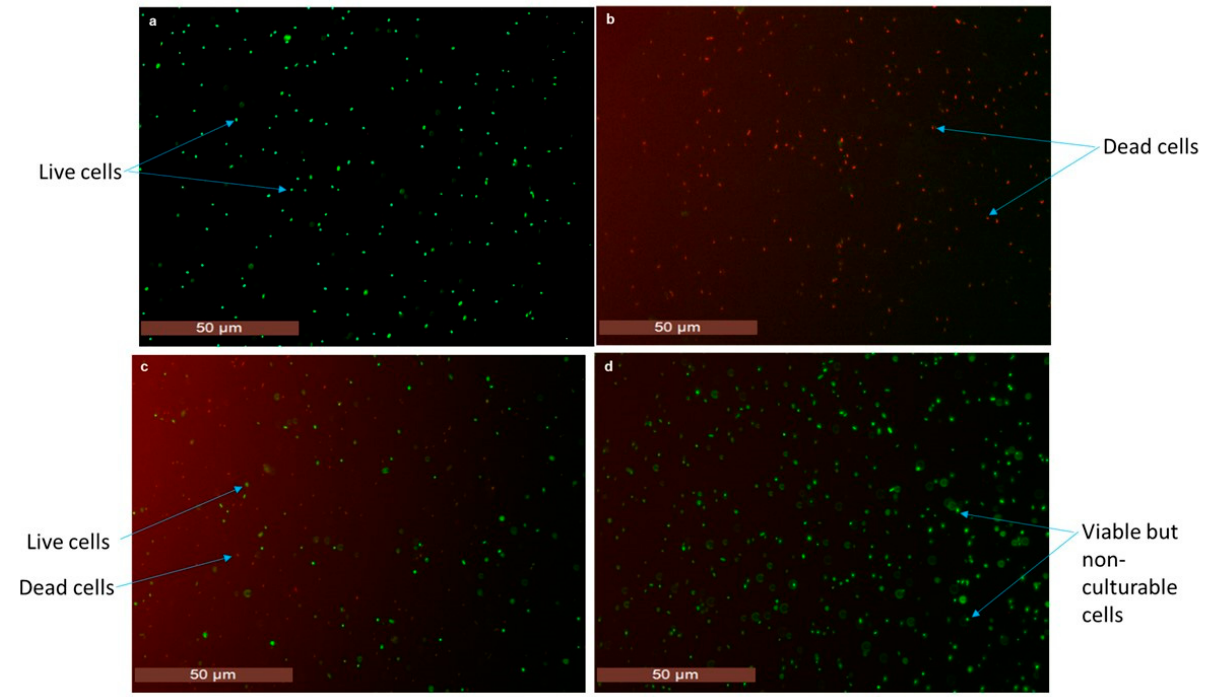
Figure 1. Characterisation of the E. coli O157:H7 strain using fluorescence microscopy with the LIVE/DEAD BacLight Viability Kit. ( a ) 100% live bacteria. ( b ) 100% dead bacteria. ( c ) Mixed live:dead (50:50) bacteria. ( d ) VBNC bacteria. Green and red fluorescence represent live and dead cells,